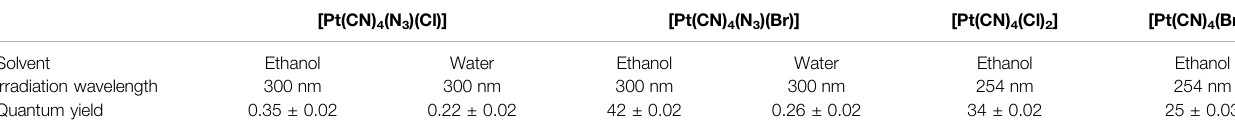
TABLE 3 | Quantum yields of the cyano fragment [Pt(CN) 4 ] 2 − derived from [Pt(CN) 4 (X)(Y)] under light irradiation at various wavelength [adapted from Vogler et al.